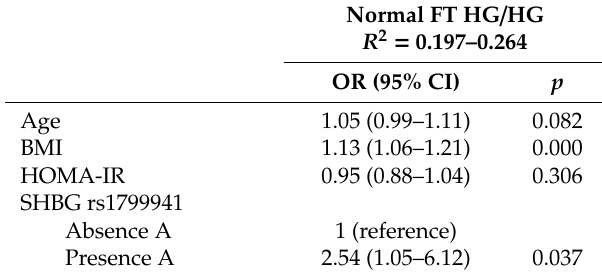
Table 5. Logistic regression analysis adjusted by age, BMI and HOMA-IR. Likelihood of presenting